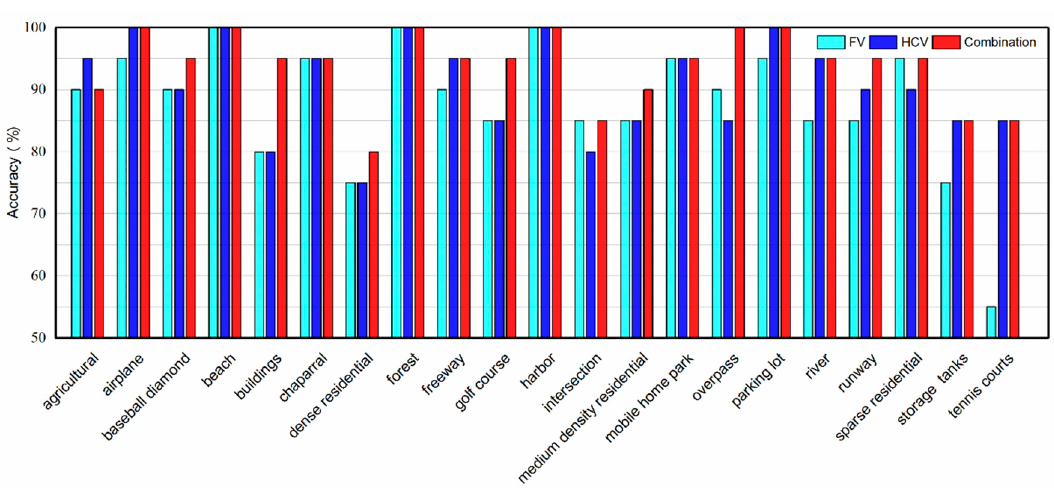
Figure 6 . Comparison of the pre-class accuracies of Hierarchical Coding Vector (HCV) with the Fisher Vector (FV) and the combination of the two on the LU database.